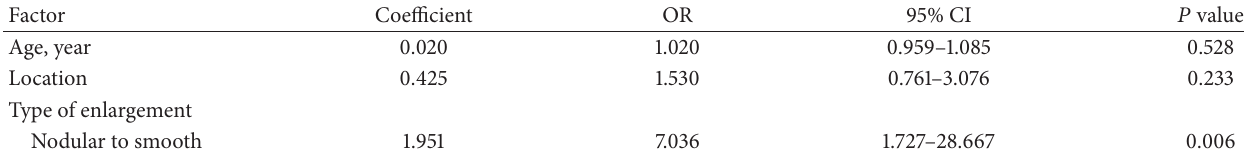
Table 3: Multiple regression analysis of the risk factors of functional lesions.